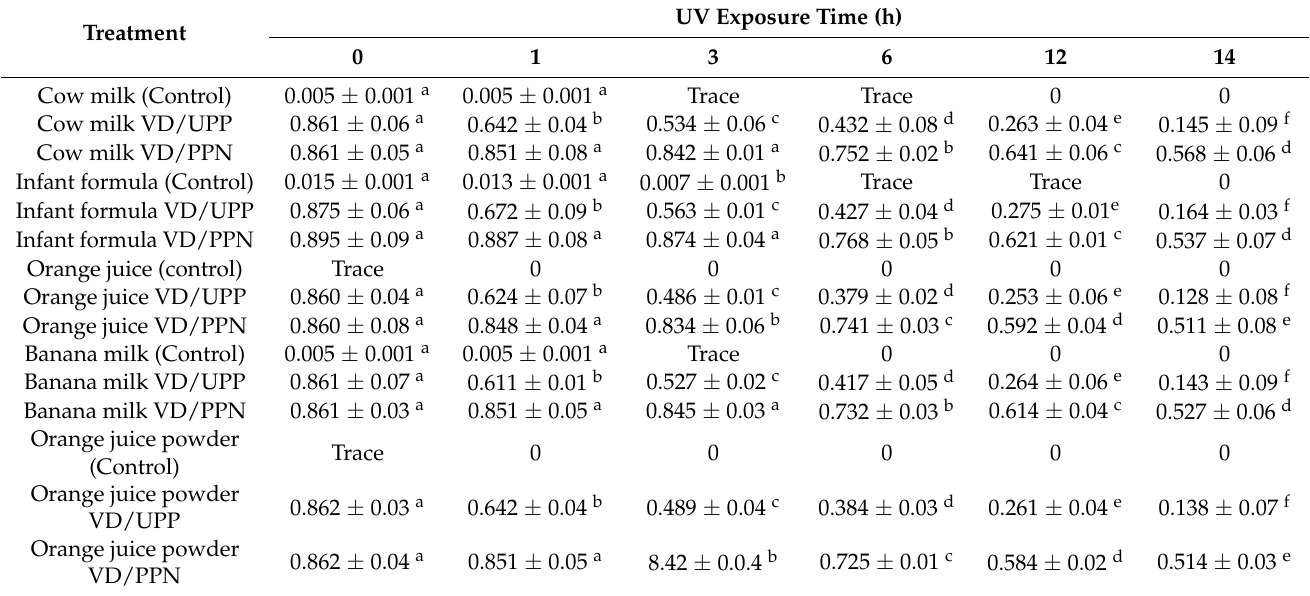
Table 6. Vitamin D content ( µ g/100 mL) in all food products over 24